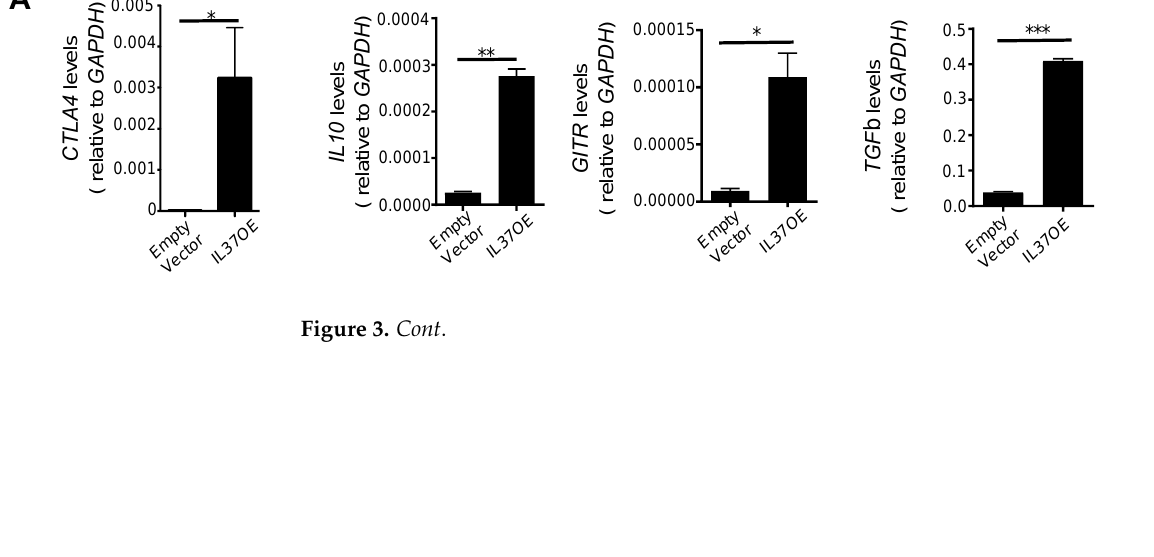
Figure 3 . IL-37 overexpressing Jurkat cells are phenotypically similar to Treg cells. ( A ) qRT-PCR analysis of CTLA4, IL10, GITR , and TGFB mRNA expression in vector control and IL37 OE Jurkat cells. GAPDH served as an internal control, and the values represent the gene expression level as a ratio to GAPDH expression. ( B ) CTLA-4 protein expression in vector control and IL37 OE Jurkat cells. Histograms (upper) and quantification by mean fluorescent intensity (MFI) (lower) of CTLA- 4 expression. IgG was used for negative control staining (solid gray histogram). ( C ) Left, contour plots of IL-10+ cell gating in unstimulated and anti-CD3/CD28 treated vector control and IL37 OE Jurkat cells. Right lower, quantification of the percentage of IL-10+ Jurkat cells. IgG was used for gating for positive staining. Small horizontal lines indicate mean ± s.e.m. * p < 0.05; ** p < 0.01; *** p < 0.001; **** p < 0.0001 (Student’s t test). Data are representative of four independent experiments. These data confirm that IL-37 overexpression in Jurkat cells induced a Treg cell phe- notype. It is known that both CTLA-4 and IL-10 play a significant role in suppressing an adaptive immune response [17 – 19], suggesting that IL-37 overexpression in Jurkat cells also induces Treg functionality. 3.3. IL37 OE Jurkat Cells Suppress Naïve CD4+ T Cell Proliferation Comparable to Human Primary Treg Cells Since FOXP3 expression is integral in Treg suppressive function, we examined if IL37 OE Jurkat cells exhibited suppressive function in vitro. Freshly isolated human CD4+CD25 lo T cell responder (Tresp) cells were labeled with CFSE and co-cultured in CD3-stimulatory conditions for 5 days with either control Jurkat cells or IL37 OE Jurkat cells . Human primary Treg cells were used as a positive control. We found that the co- culture of Tresp cells with IL37 OE Jurkat cells significantly suppressed the proliferation of Tresp cells (~50% reduction compared to control Jurkat cells), comparable to human C T L un s t i m